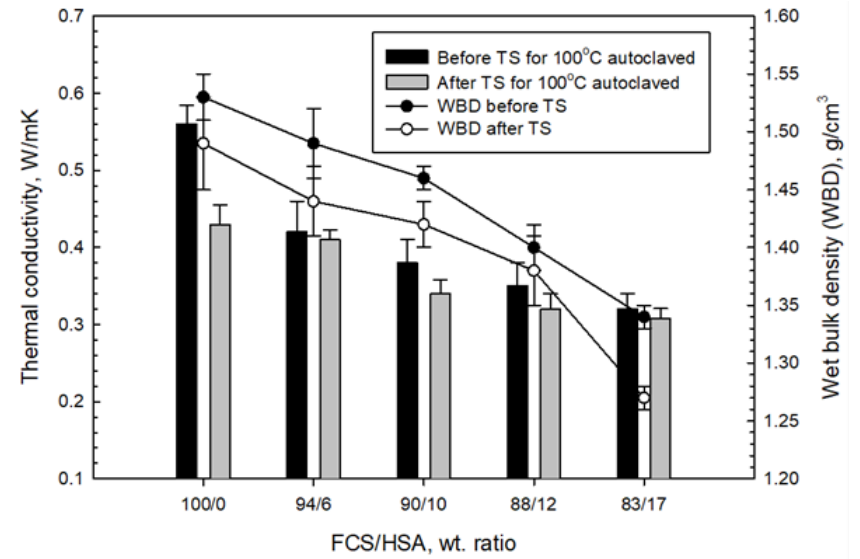
Figure 32. Thermal conductivity and wet bulk density of 100 °C-autoclaved CaP composites made with various FCS/HSA ratios before and after TS.